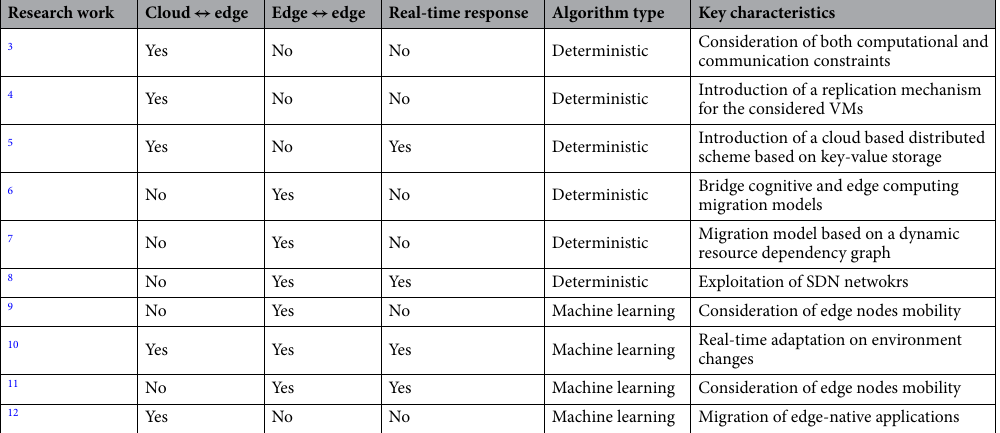
Table 1. Summary of the state-of-the-art reviewed research